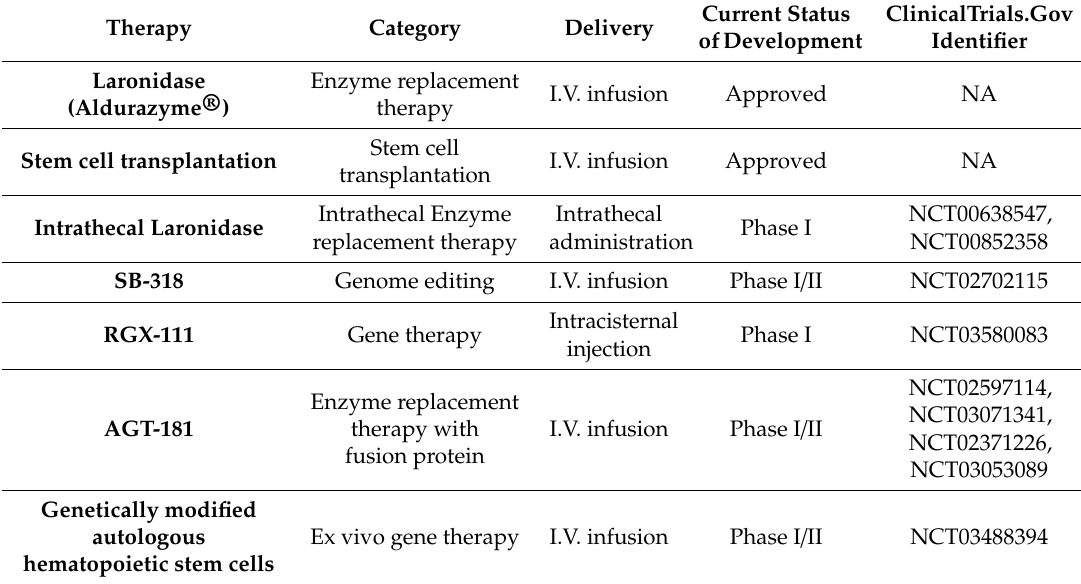
Table 2. Therapeutic approaches approved and in development for MPS